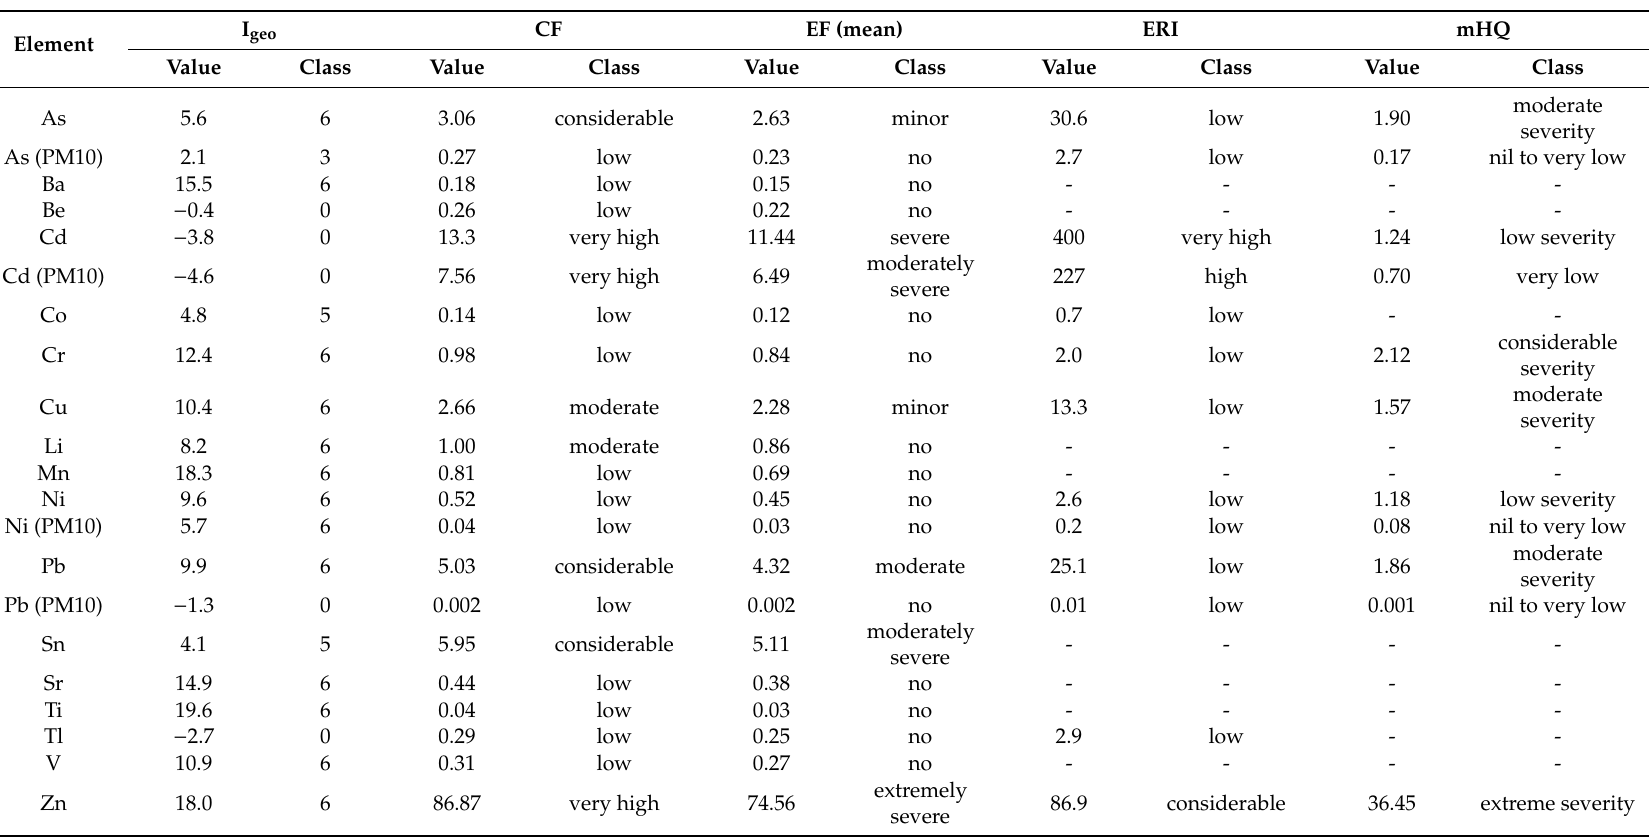
Table 6. Enrichment index classes for deposited PM in Krak ó w (modified after [49]). I geo : geoaccumulation index, CF: contamination factor, EF: enrichment factor, ERI: ecological risk index, mHQ: modified hazard